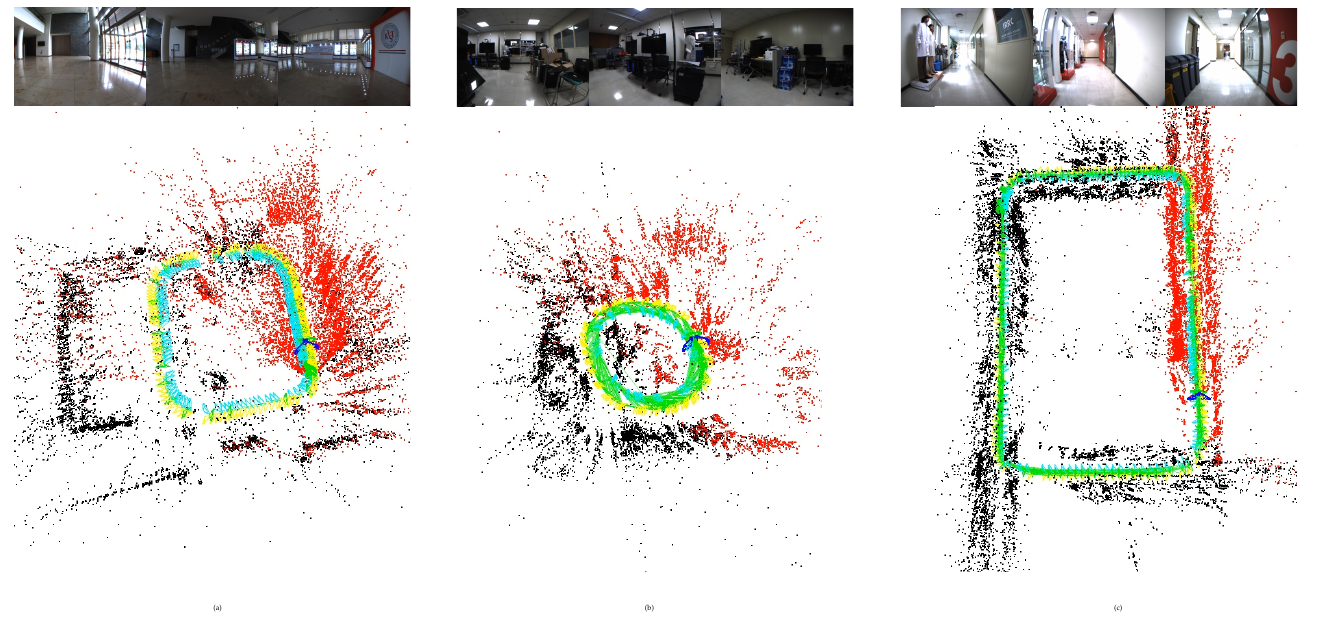
Figure 8. The multi-camera trajectories of the proposed method with some real image sequences of the scenarios. ( a ) KIST-00, ( b ) KIST-01, and ( c ) KIST-02 sequences. The current reference camera is indicated green while the nonreference cameras are shown with navy color. Additionally, each camera’s keyframes are shown with different colors. The keyframes created by the reference camera are shown with green color, and the nonreference cameras’ keyframes are indicated yellow and turquoise colors. Additionally, local map points are shown with red color, while black map points represent the fixed map points that are not being processed